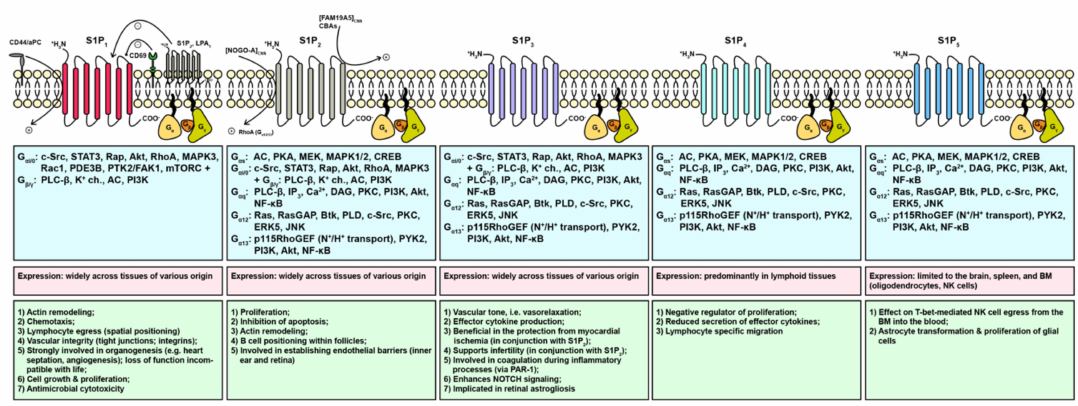
Figure 2. Sphingosine 1-phosphate receptors, canonical pathways, and functions